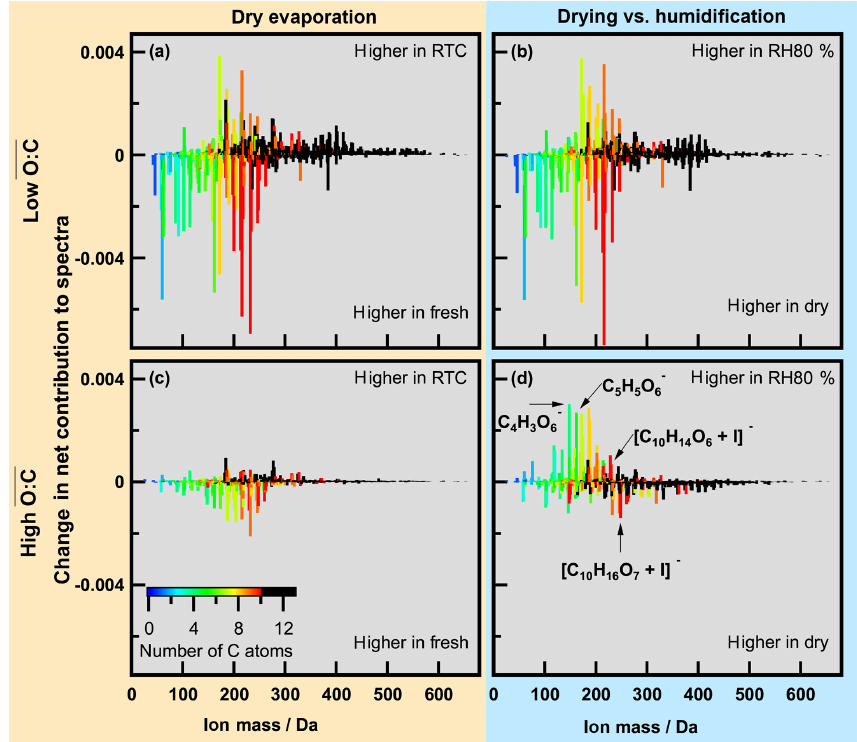
Figure 3. Changes in normalized spectra for low O : C (a, b) and high O : C (c, d) . (a, c) Changes due to evaporation under dry conditions; (b, d) changes between dry and wet conditions. Colour indicates number of C atoms in the identified ions (black corresponds to C number larger than 10). Mass spectra were normalized by total signal, and then the difference was